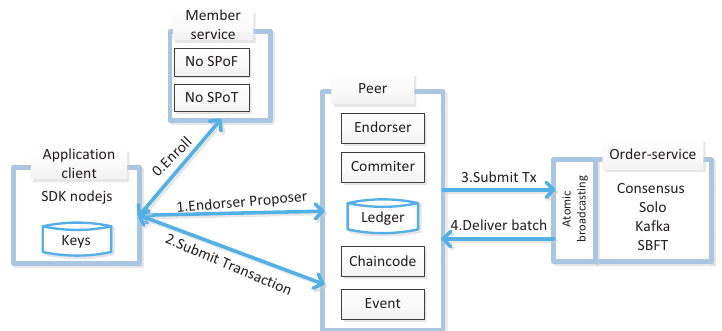
Figure 3. Transaction Architecture of Fabric.